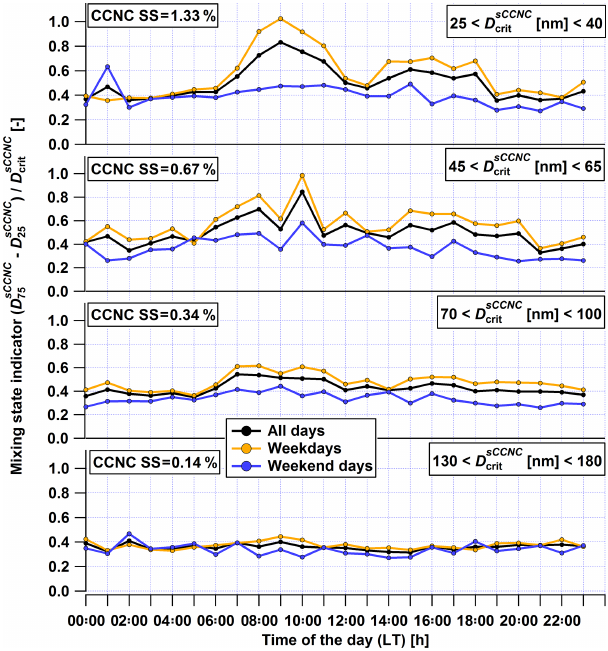
− D sCCNC )/D sCCNC Figure 5. Diurnal patterns of (D sCCNC from 75 25 crit sCCNC measurements as an indicator of the particle mixing state, averaged during the whole campaign (the larger the value the more externally mixed with respect to hygroscopicity). Results at four dif- ferent SS are separately averaged over the whole campaign includ- ing all days, weekdays only or weekend days only. The approximate ranges of D sCCNC corresponding to the respective SS are indicated crit on each